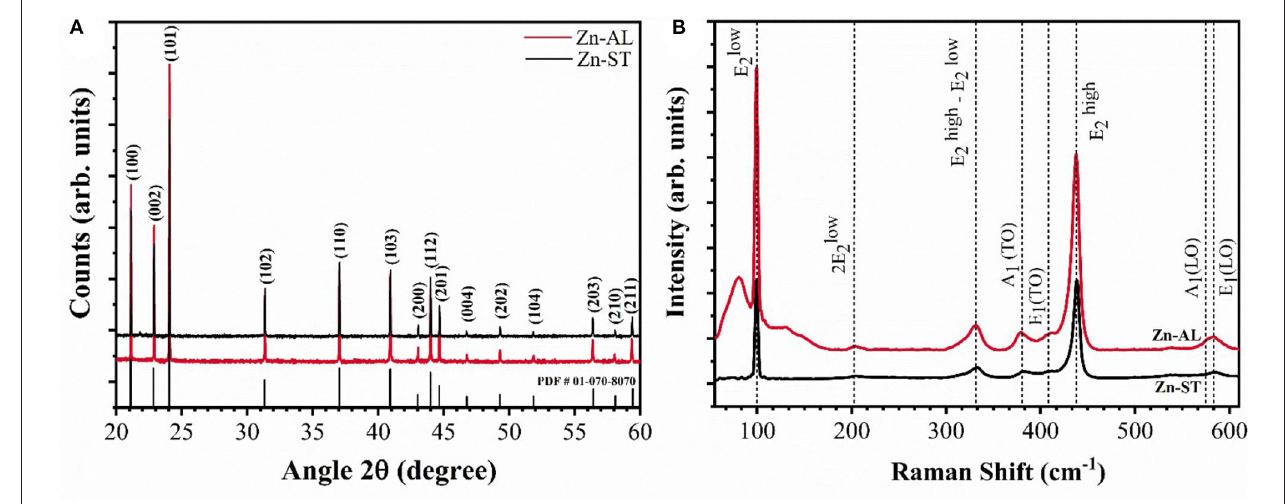
FIGURE 1 | (A) XRD pattern and (B) Raman spectrum of the ZnO samples.